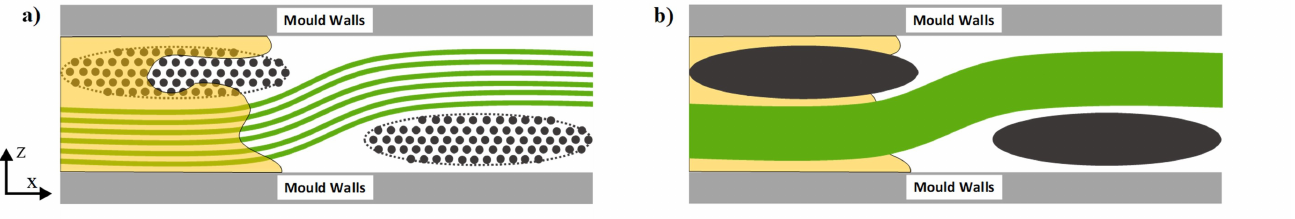
Figure 2. Flow regions for permeability prediction: ( a ) permeable tows, ( b ) impermeable tows ( φ t =